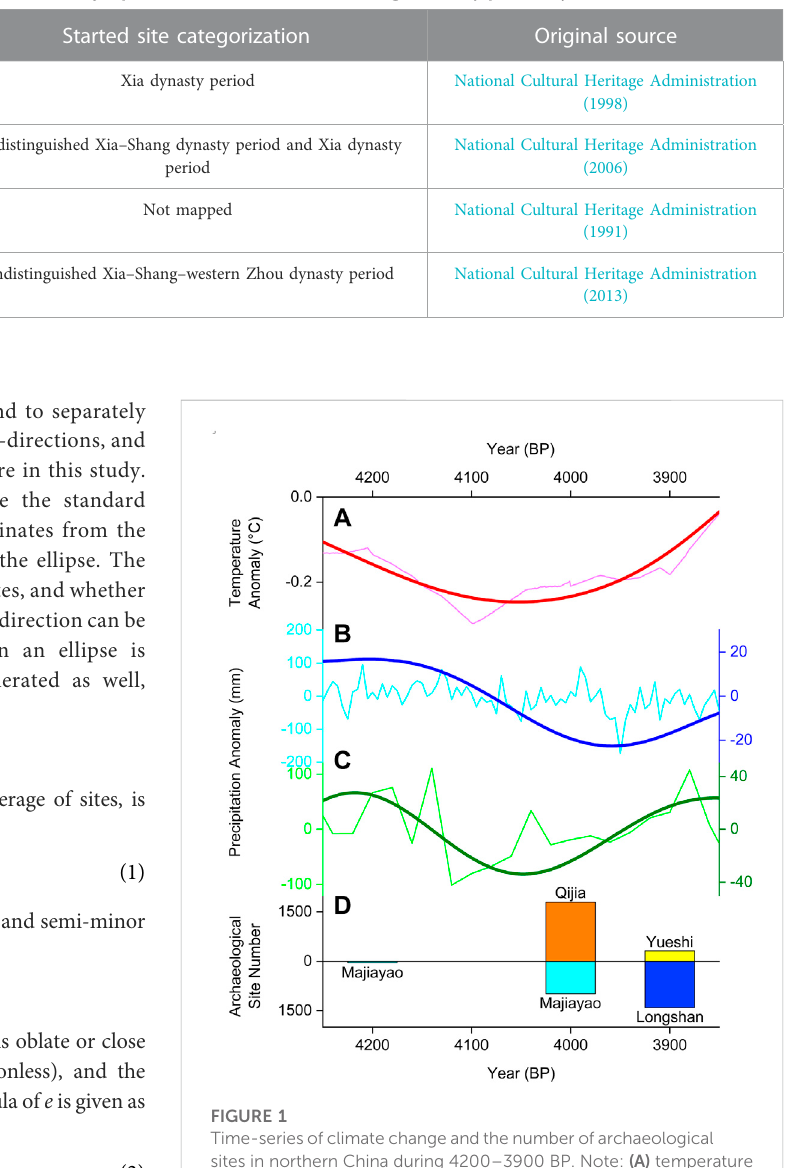
TABLE 1 Categorization of the ended and started sites in the four major provinces of northern China during the study period (by Hosner et al., 2016).